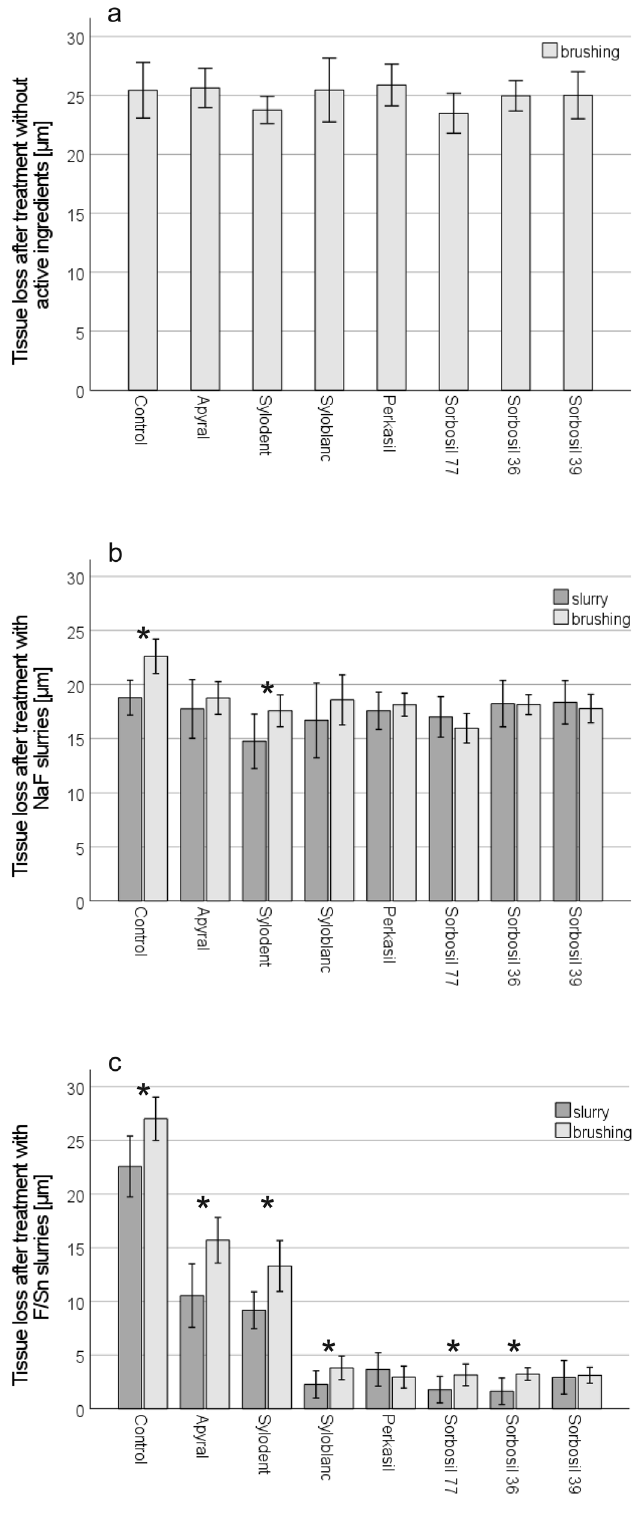
Figure 1. Tissue loss (mean ± SD) at the end of the experiment (T4) after treatment with slurries containing one of the various particle types each or control (distilled water). Slurries were prepared either without active ingredients ( a ), with NaF ( b ) or with F/Sn ( c ). Asterisks indicate a significant difference in tissue loss after slurry alone compared to additional brushing (level of significance .006 after Bonferroni adjustment). Significances between the particle types after treatment with the slurries only (dark grey columns) or after additional brushing (light grey columns) are shown in Table